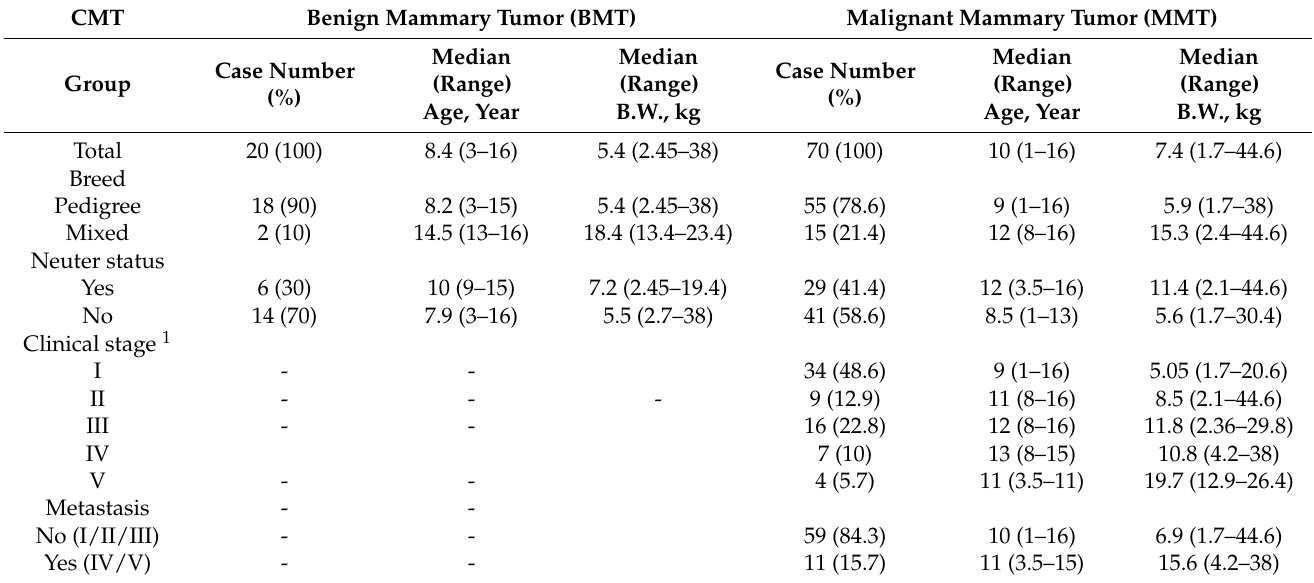
Table 1. Clinicopathological characteristics of 90 female dogs with mammary tumors enrolled in the overall survival